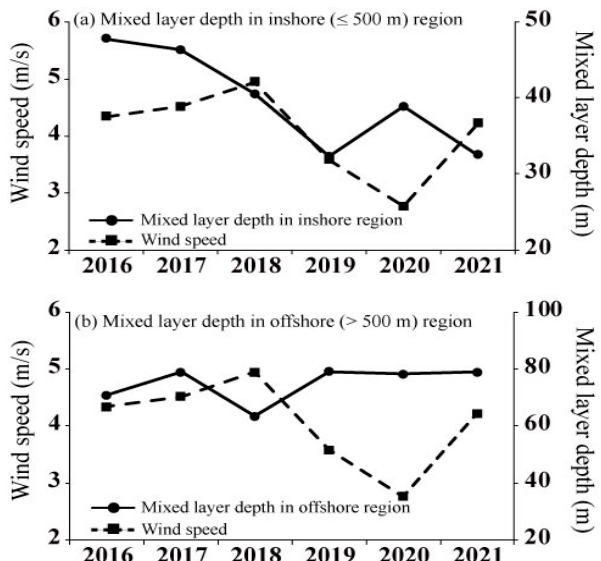
Figure 6. Inter-annual changes in the averaged mixed layer depth (MLD) of ( a ) offshore and ( b ) in- shore regions, along with wind speed in the western part of East/Japan Sea